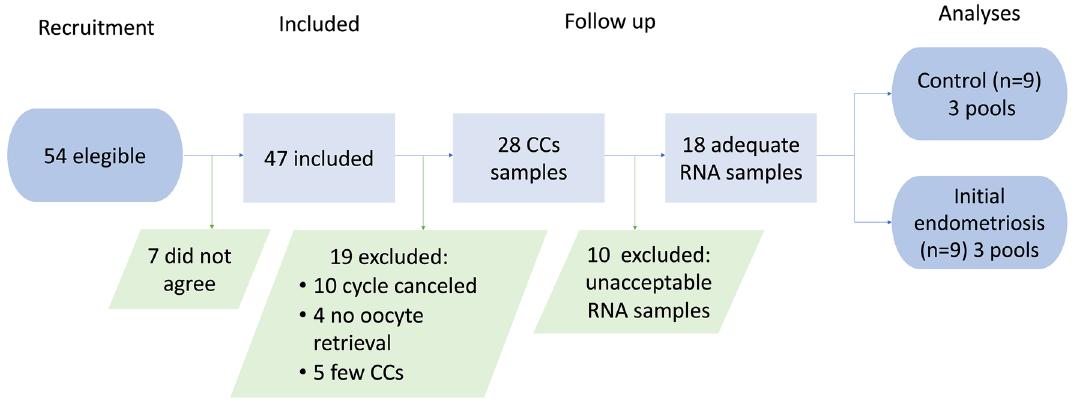
Figure 1. Flowchart of the